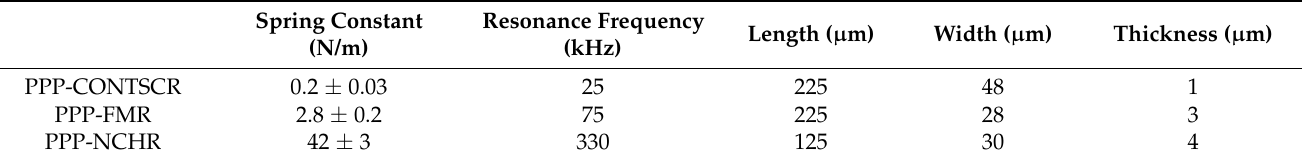
Table 1. Specifications of three cantilevers used for evaluating the effect of cantilever stiffness on Young’s modulus calculations.